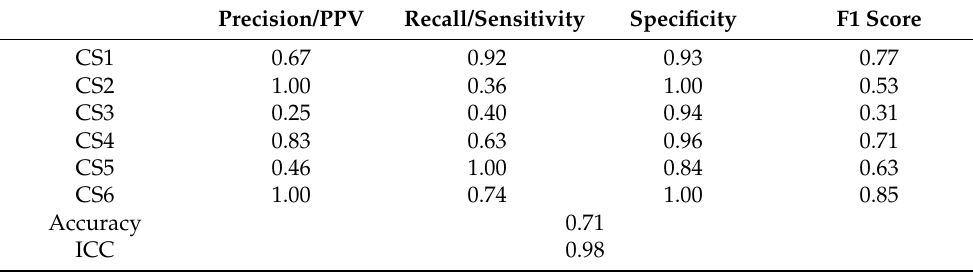
Table 4. The evaluation of CVM staging through